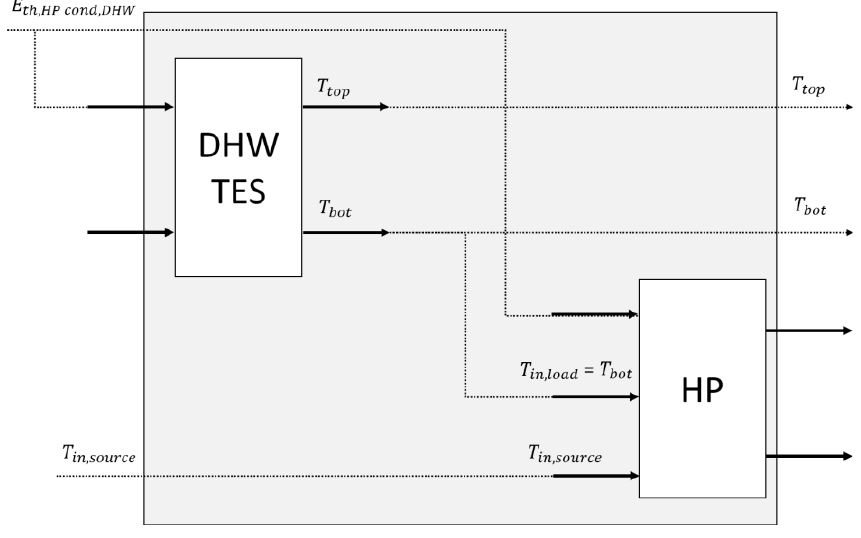
Figure 8. Block diagram of the 5GDHC ETS composite ANN model.